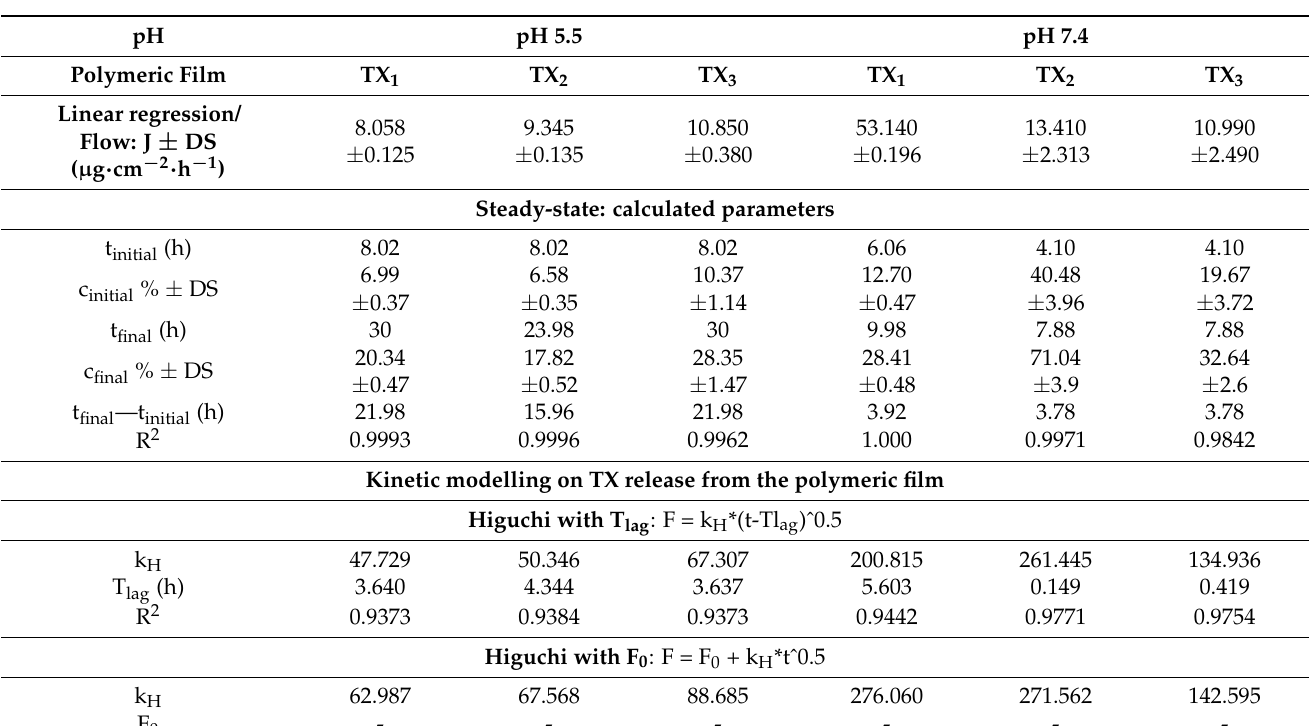
Table 3. The kinetic parameters for